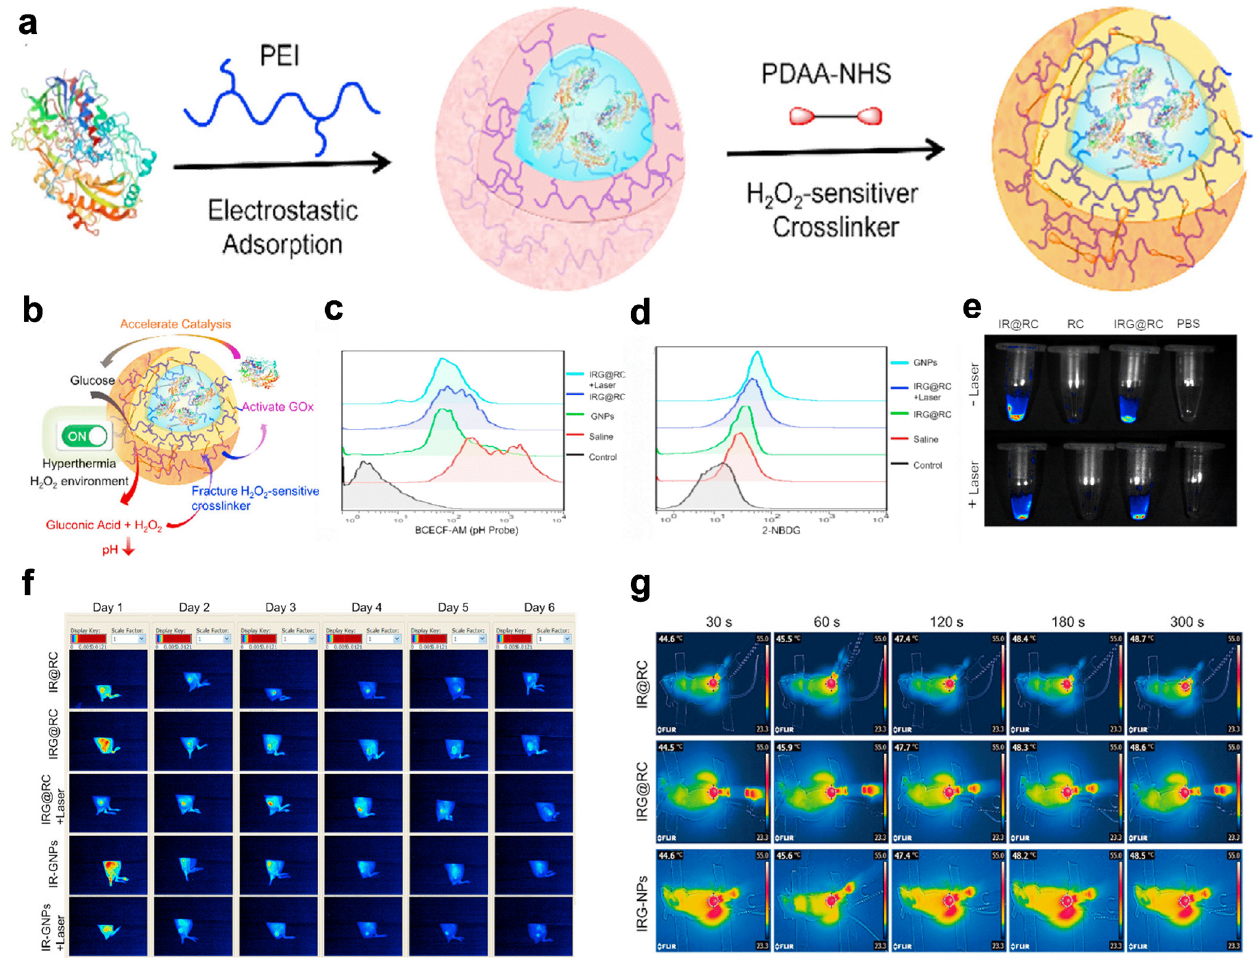
Figure 6. GNPs for FLI and infrared thermography. ( a ) Fabrication process of GNPs. ( b ) Schematic illustration of the catalytic activity of GNPs. ( c , d ) H 2 O 2 content in tumor tissue determined with an H 2 O 2 detection kit. Flow cytometry images of the pH probes BCECF-AM © and 2-NBDG ( d ) to determine the cellular pH value and glucose consumption, respectively. ( e ) Ex vivo fluorescence images of RC, IR@RC, and IRG@RC with/without laser irradiation. ( f ) In vivo fluorescence images of tumor-bearing mice. ( g ) Thermal imaging at the tumor site after laser irradiation by in vivo infrared thermography. Reproduced with permission from Ref. [108]. Copyright © 2022 The Authors. Published by Elsevier